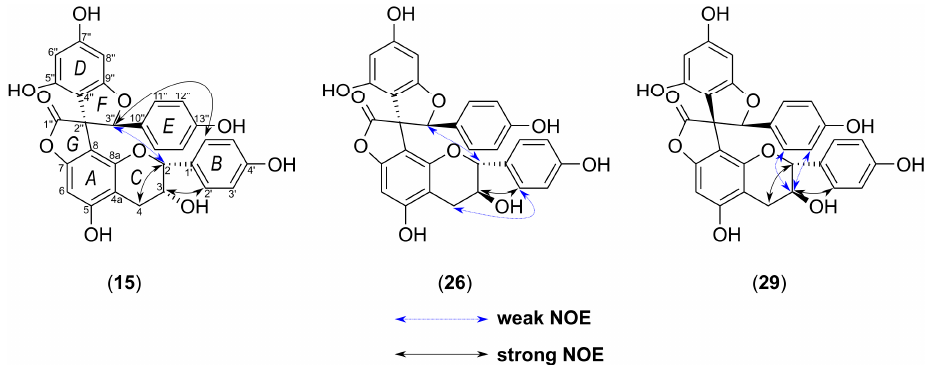
Figure 5. Structures of compounds 15 , 26, and 29 isolated from the bark of Y. schidigera and key nuclear Overhauser effect (NOE) correlations.